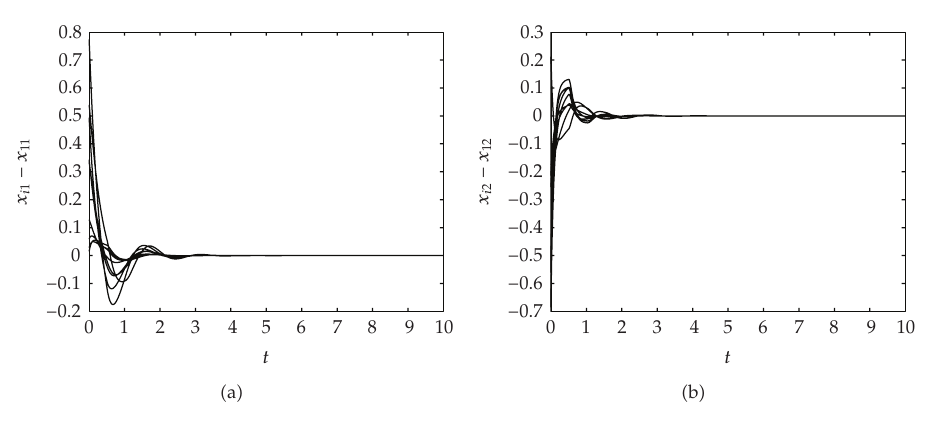
Figure 1: Synchronization error of system (cid:3) 4.1 (cid:4)